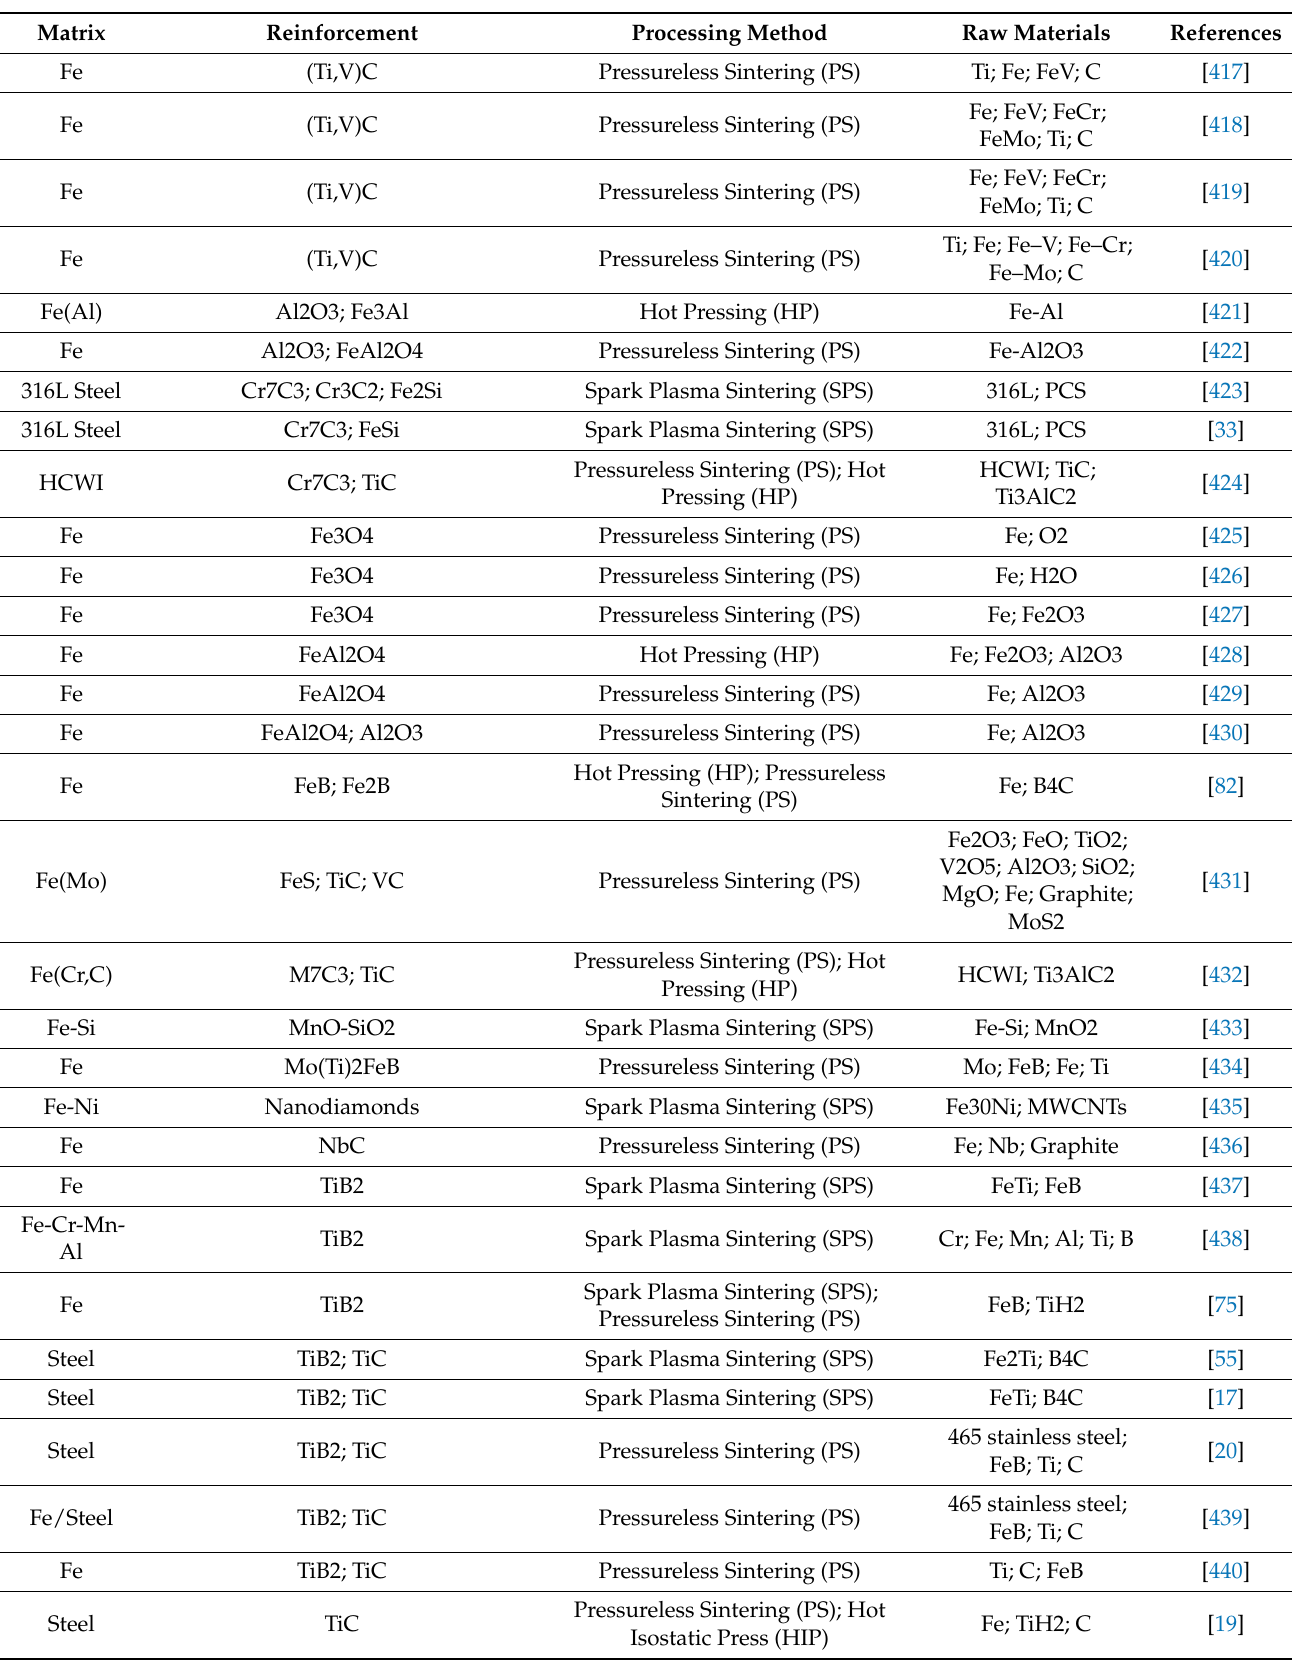
Table A6. Iron and Steel Matrix